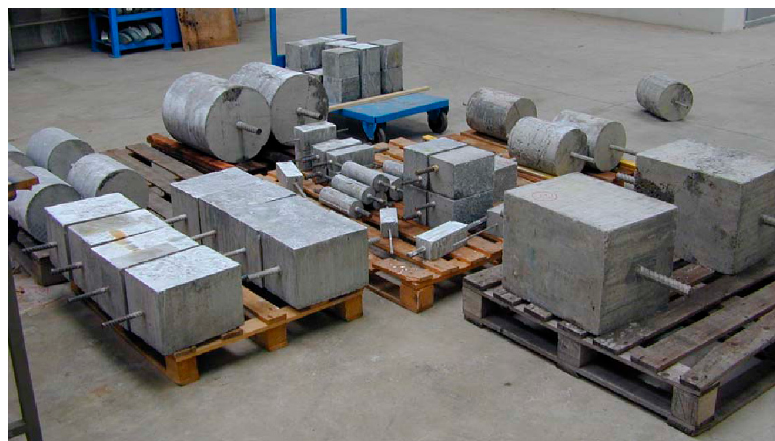
Figure 4. Overview of the realized specimens.